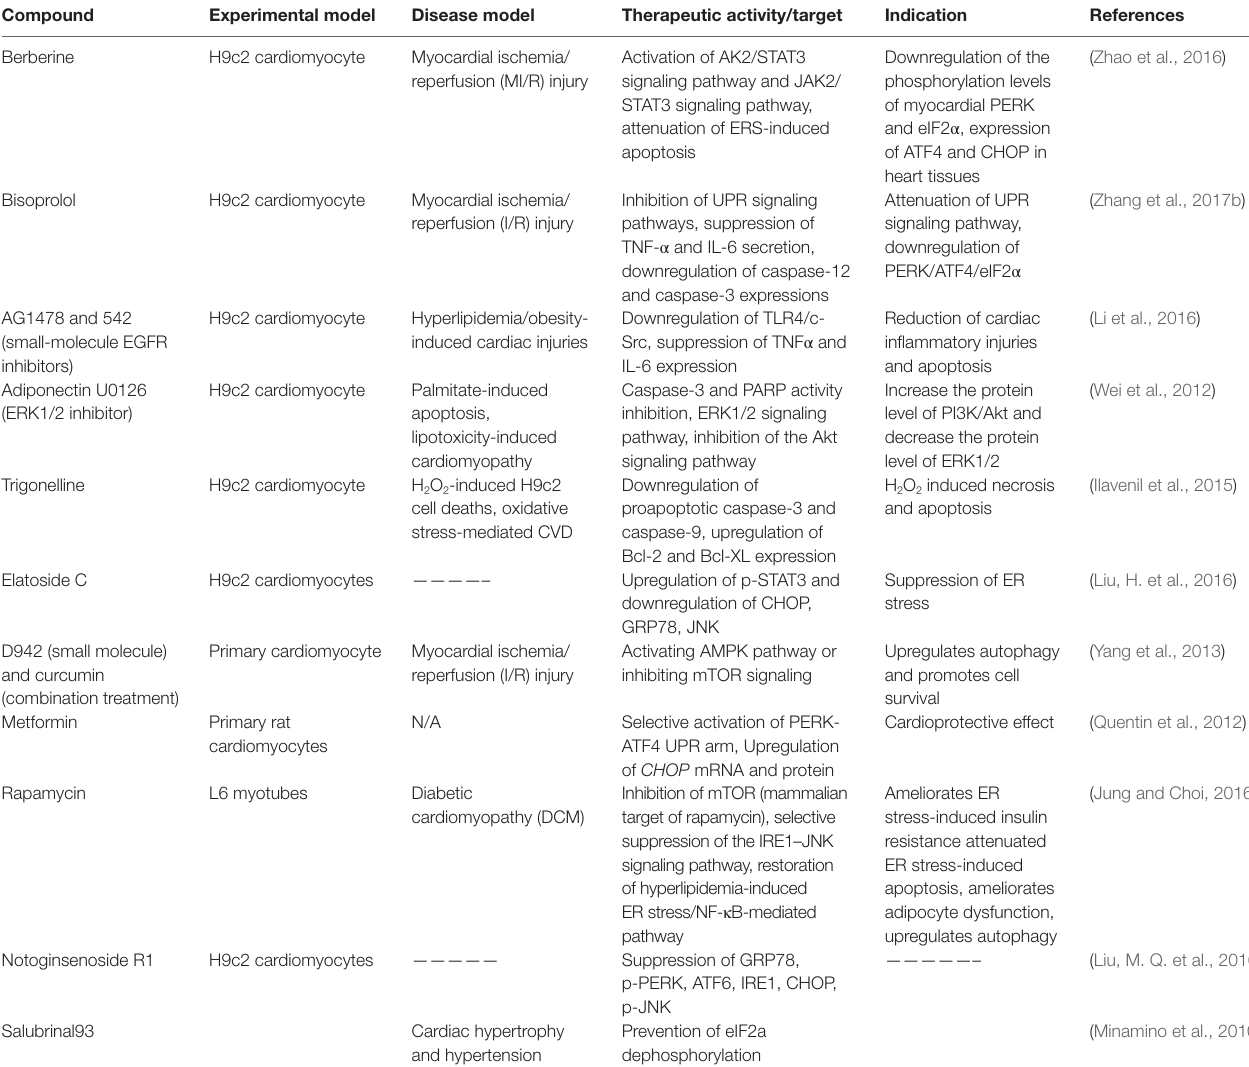
TABLE 2 | Preclinical therapeutics (natural compounds, small molecules, or peptides) targeting the UPR signaling pathway ( in vitro